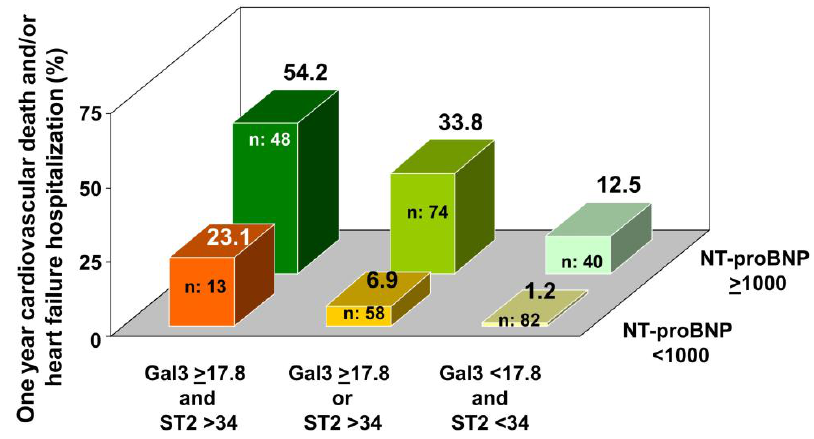
Figure 1. The probability of one-year events according to the combination of the presence of increased NT-proBNP and increased ST2 and/or Gal-3 is